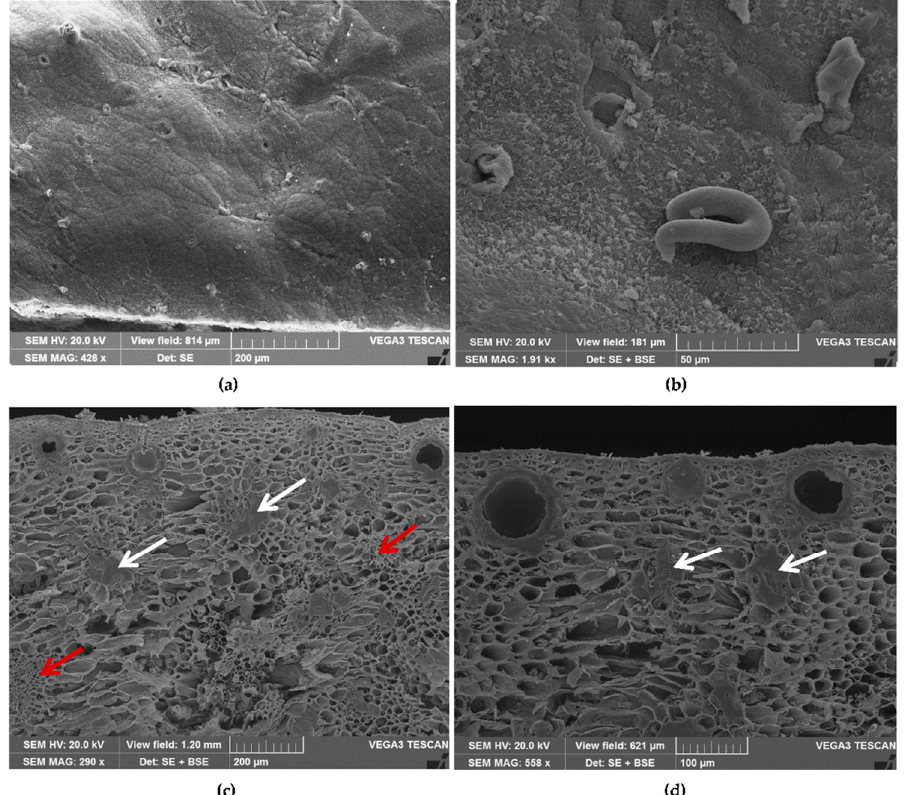
Figure 1. SEM micrographs ( a – b ). Epidermis of the exocarp with scattered stomata, openings of secretory cavities, and simple unicellular trichomes ( a , b ). Transversal sections of the fruit peel, showing a parenchima rich in schizogenous secretory cavities, located near the epidermis ( c , d ), stone cells ( c , d , white arrows), and vascular bundles ( c , red arrows).